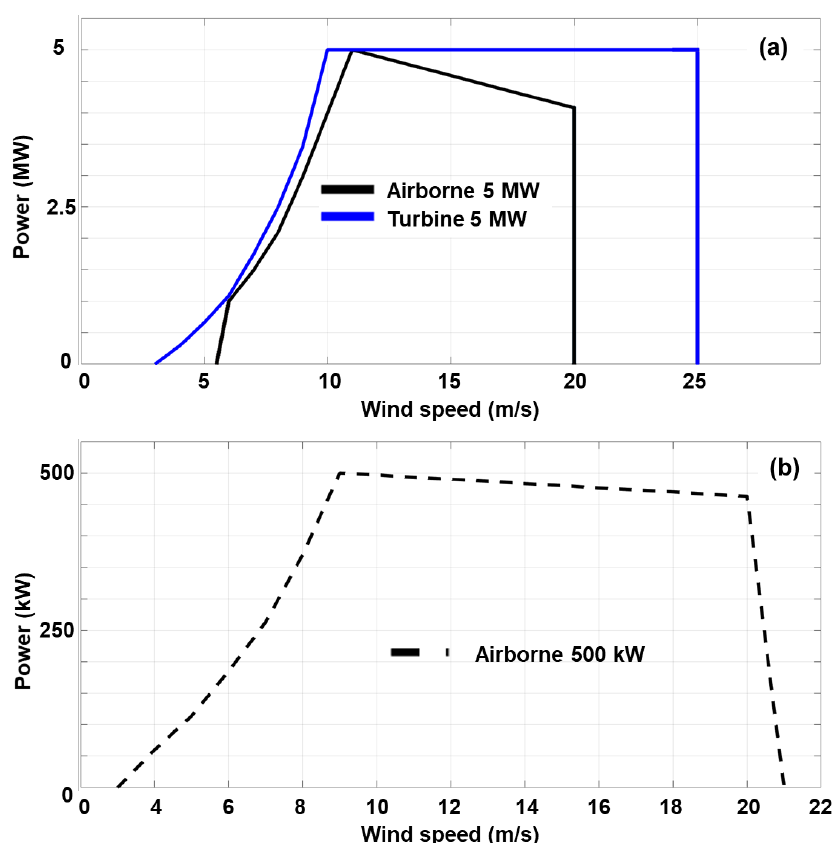
Figure 1. Power curves of the wind turbines according to Weber et al. [35]: ( a ) 5 MW generators—airborne and turbine; ( b ) airborne—500 kW version.